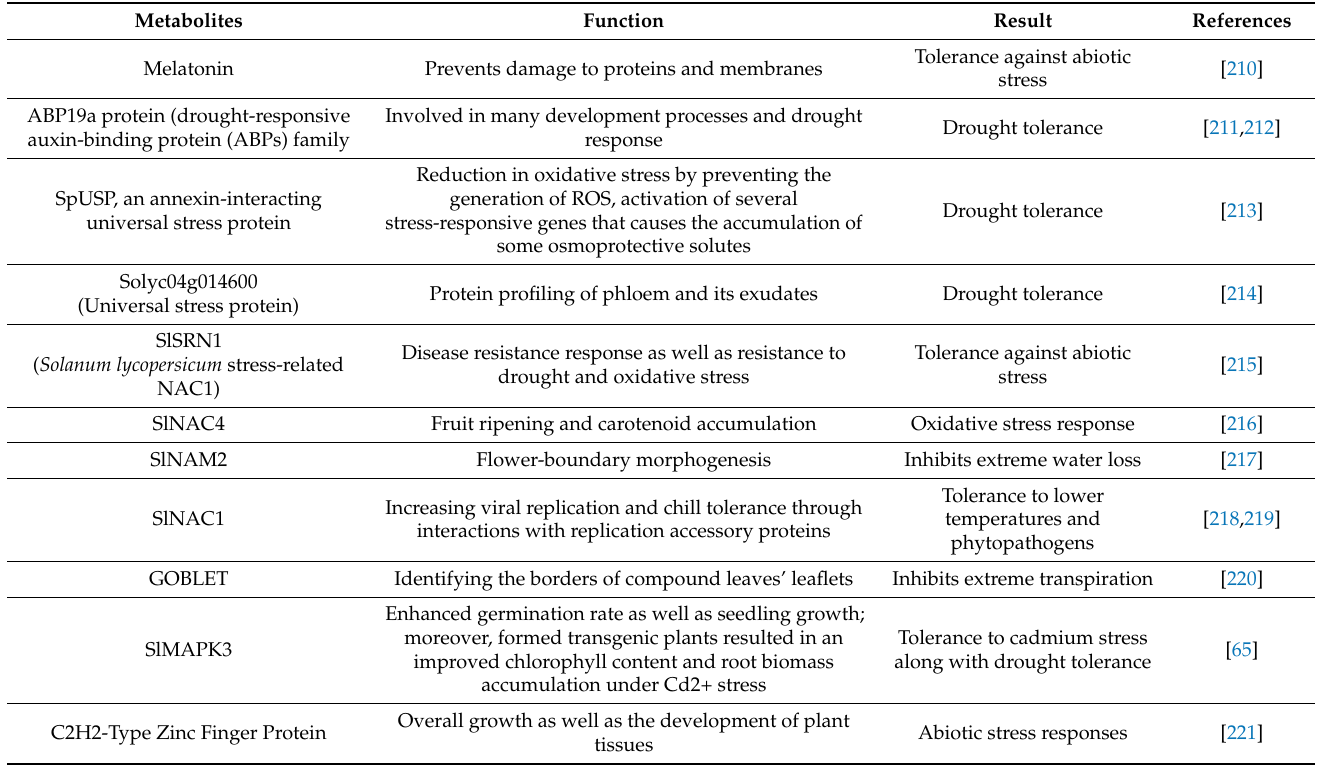
Table 3. Metabolites involved in abiotic stress tolerance in